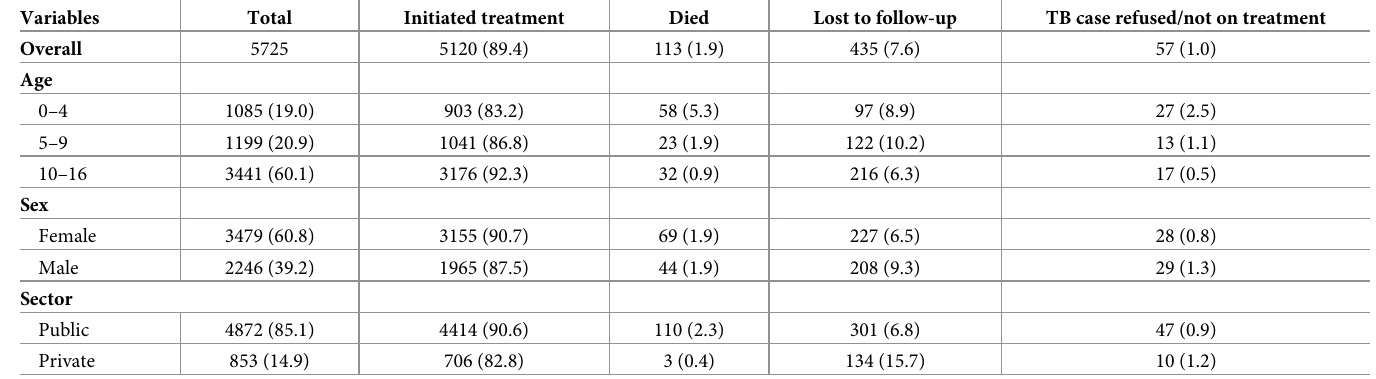
Table 4. Treatment initiation status of bacteriologically confirmed rifampicin sensitive TB cases.